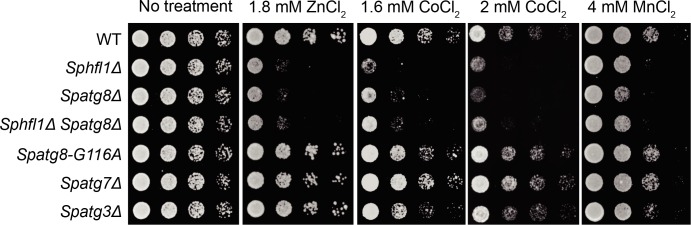
Spatg8Δ Sphfl1Δ double mutant exhibited no enhanced metal sensitivity compared with the two single mutants, and mutants defective in Atg8 lipidation did not show metal hyper-sensitivity.